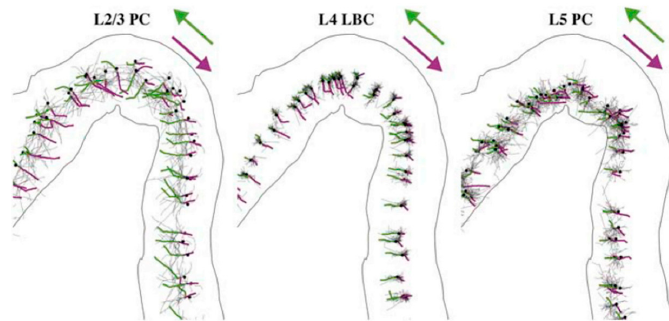
Figure 6. Action potential initiation points in the primary motor cortex layer L2/3 pyramidal cells (L2/3 PC), layer 4 large basket cells (L4 LBC), and layer 5 pyramidal cells (L5 PC) depend on the orientation. Action potentials initiate at terminal points and propagate to proximal branch points. Structures stimulated by monophasic posterior – anterior stimulation are colored in green and by anterior – posterior stimulation by magenta. Somas indicated by black dots. (Reproduced from [22].)